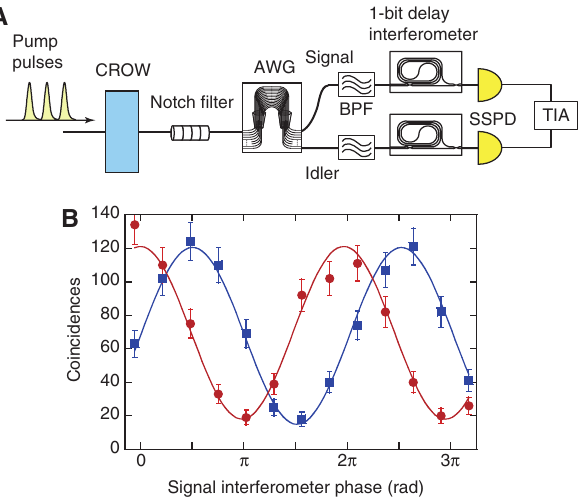
Figure 9: Time-bin entangled photon-pair generation using the